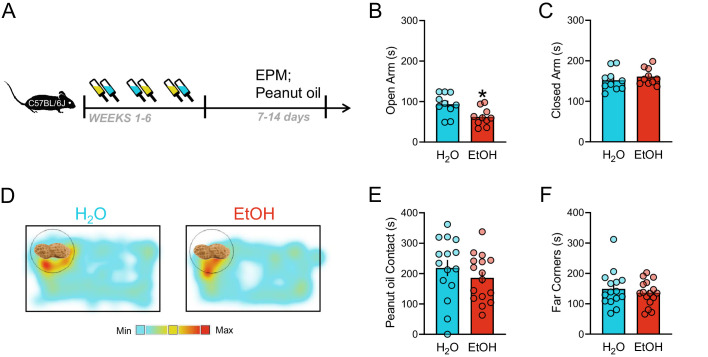
Elevated plus maze and peanut oil tests after intermittent EtOH during protracted withdrawal.(A) Schematic of elevated plus maze (EPM) and home cage peanut oil trial after 6 weeks of EtOH exposure, where time (s) spent in the (B) open arms and (C) closed arms was assessed. (D) Representative heat maps of H2O and EtOH mice with peanut oil in the home cage. (E) Contact with the peanut oil and (F) time in the far corners. *p<0.05.